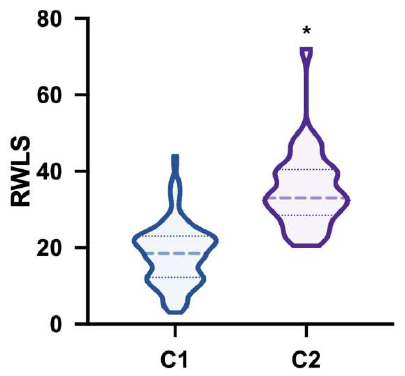
Figure 3. Rapid Weight Loss Score (RWLS) in the two clusters (C1 and C2). The thick line represents the median, while the thin ones represent first and third quartiles; Asterisk indicate statistically significant